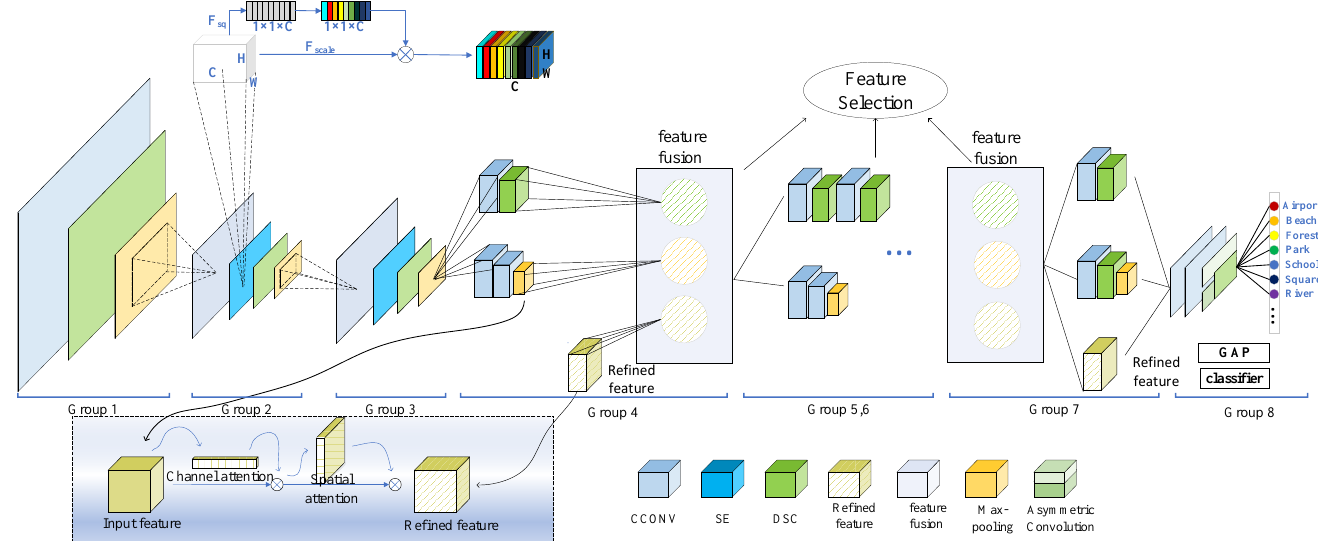
Figure 1. The proposed attention-based multi branch feature fusion convolutional neural network (AMB-CNN) network model. Algorithm 1 Framework of the proposed AMB-CNN model